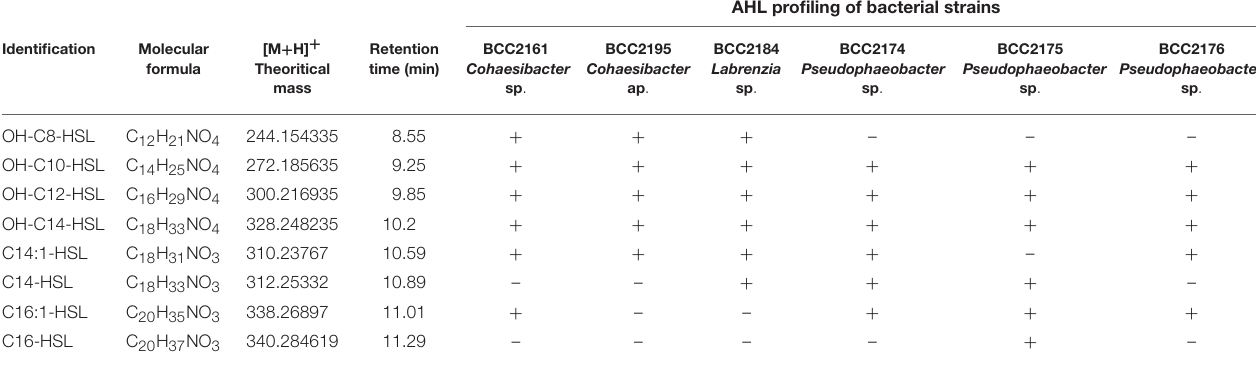
TABLE 1 | UHPLC-HRMS data of AHL profiling of bacterial